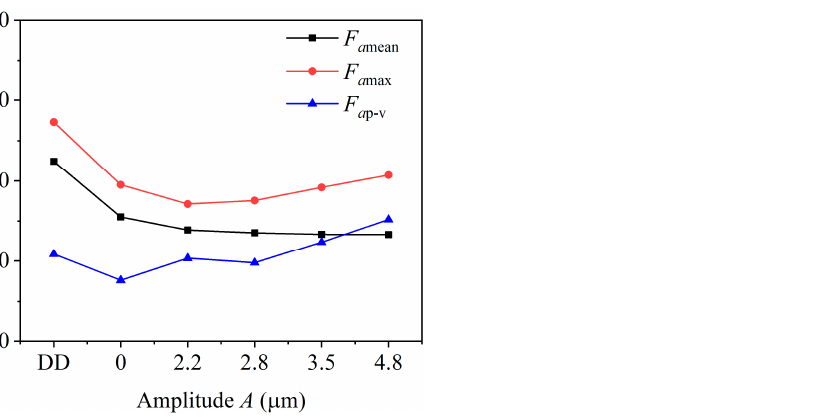
Table 3. Chip morphology comparison of UVD and UVPD. ( n = 1200 r/min, v f = 36 mm/min, f = 20